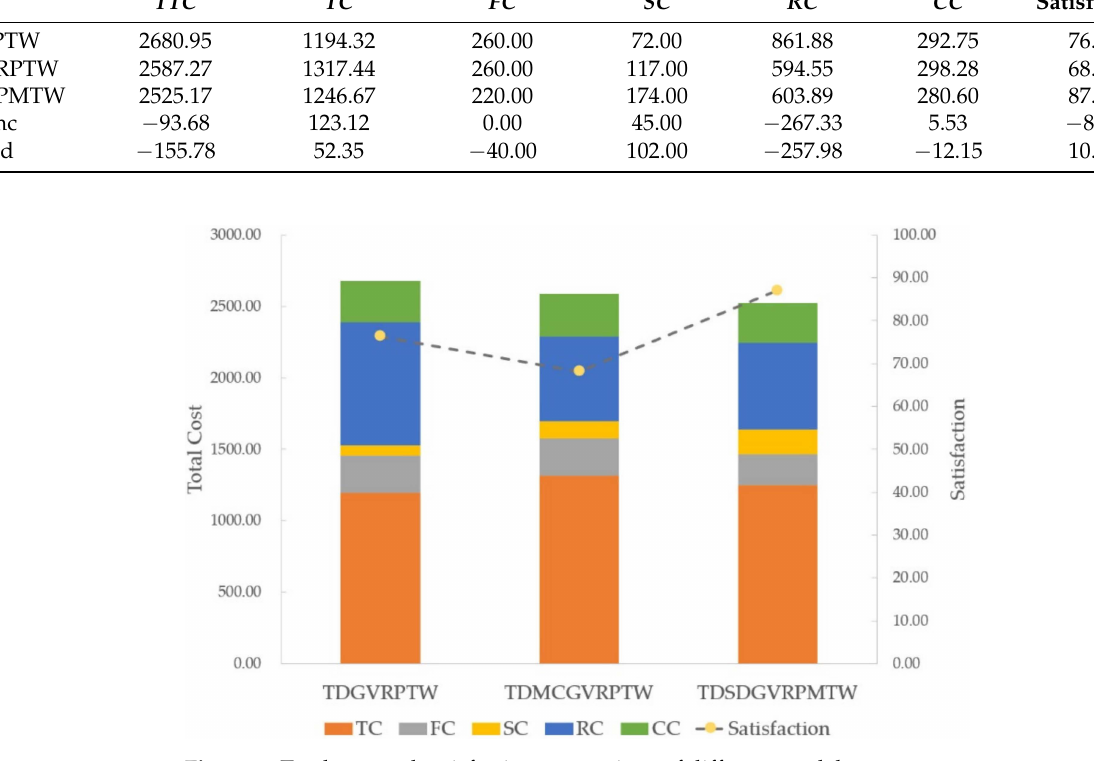
Figure 9. Total cost and satisfaction comparison of different models. Table 8. The quantity of each type of product delivered punctually under three